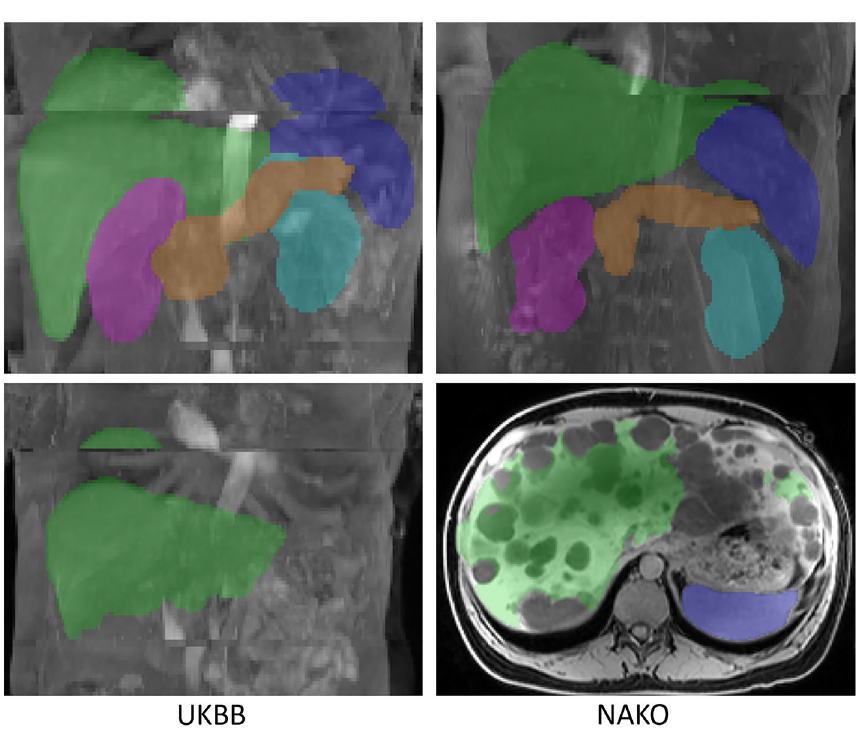
Figure 6. Examples for errors (left: UKBB, right: NAKO). Top: Example images of not largest connected component (LCC) - correctable segmentation errors caused by respiratory misalignment and resulting composing artifact of the liver and spleen (left) and the liver (right). Bottom: LCC - correctable segmentation error of the liver due to a composing artifact (left) and not LCC-correctable error of the liver due to cystic liver disease